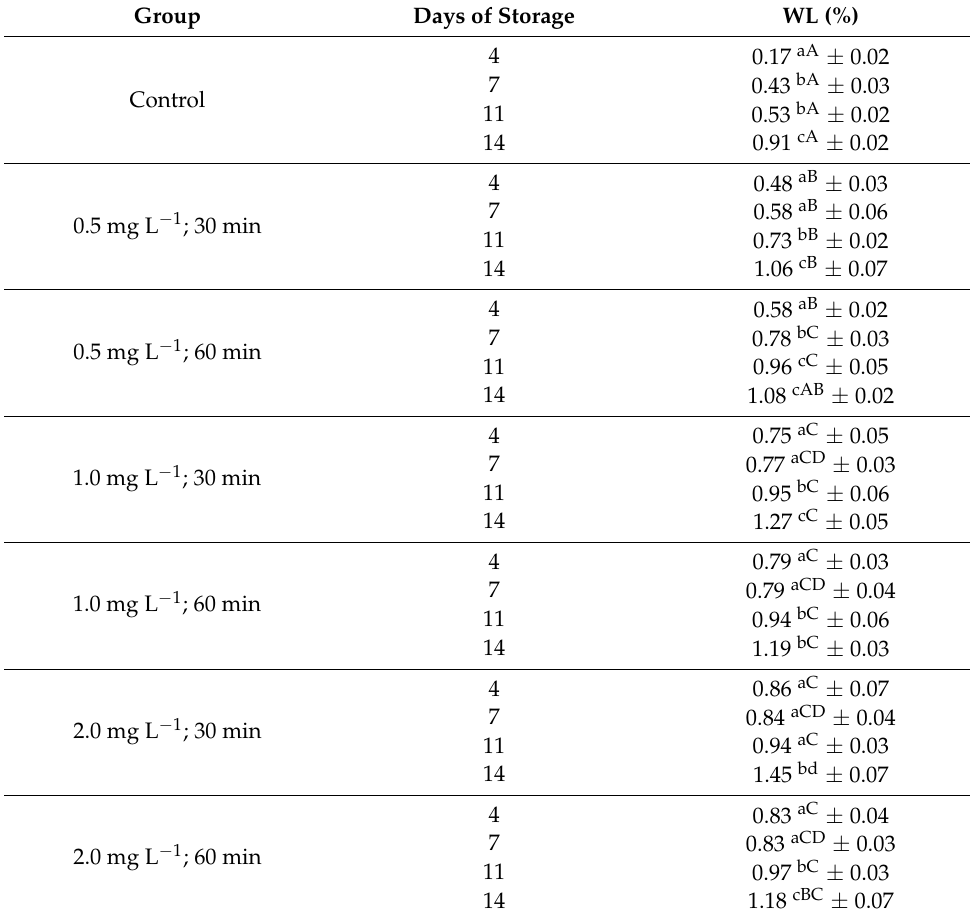
Table 2. Impact of ozone dose, time of ozonization, and storage time on weight loss (WL) (%)